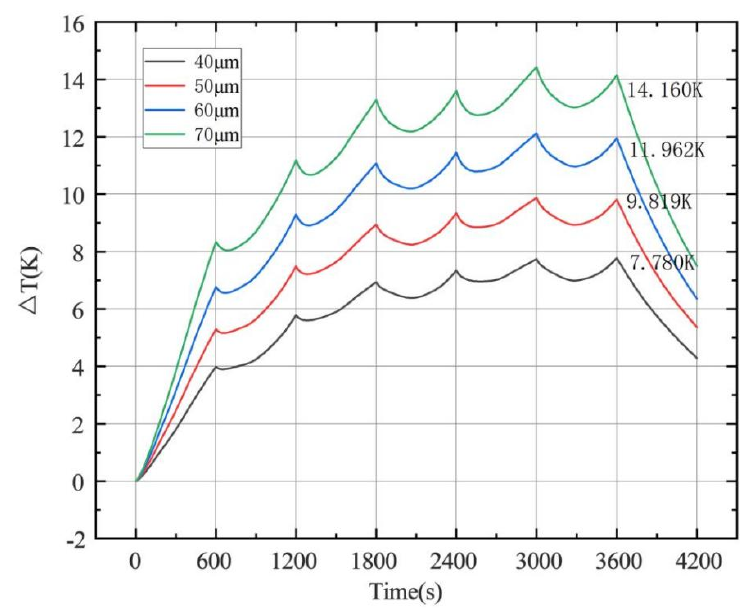
Figure 10. Average temperature changes of batteries at different electrode thickness.